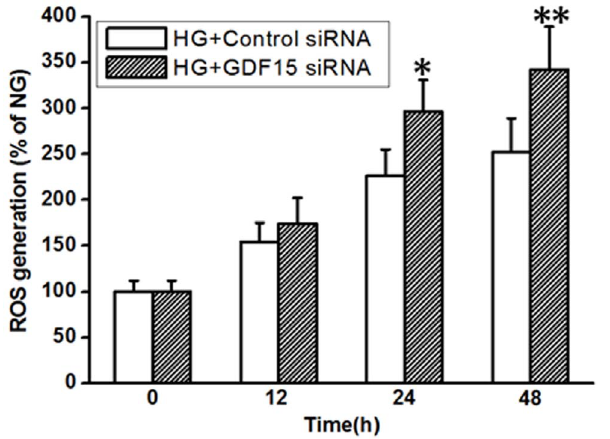
Figure 7. Inhibition of adaptively induced GDF15 expression increased ROS production. GDF15 siRNA or negative control siRNA were transfected into HUVEC cells. 12 h after transfection, HUVEC cells were treated with high (33.3 mmol/l) glucose. At indicated time points, ROS production were assayed as described in the materials and methods. HG, high glucose. *, P , 0.05, **, P , 0.01 versus Control